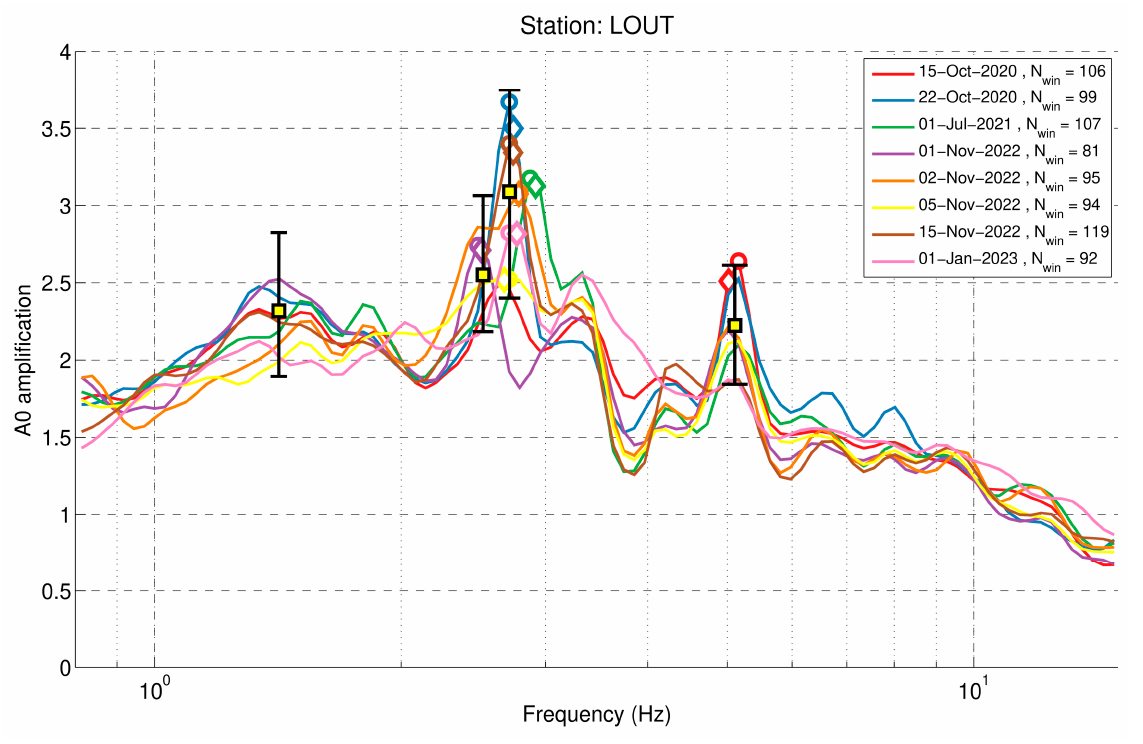
Figure 10. Average HVSR curves (solid lines) determined for station LOUT on different days, from 60 s long windows selected after the application of STA/LTA anti-triggering on 6 h long records. Circles denote the global frequency on each curve, while diamond symbols mark the average of the frequency band denoting the range of peak frequencies of the HVSR lines from the individually selected windows (light/dark gray band in Figure 2b). Squares mark the prominent global and secondary peak frequencies recognized from the HVSR spectra, with error bars indicating the uncertainty of the amplification factor (Table A1).